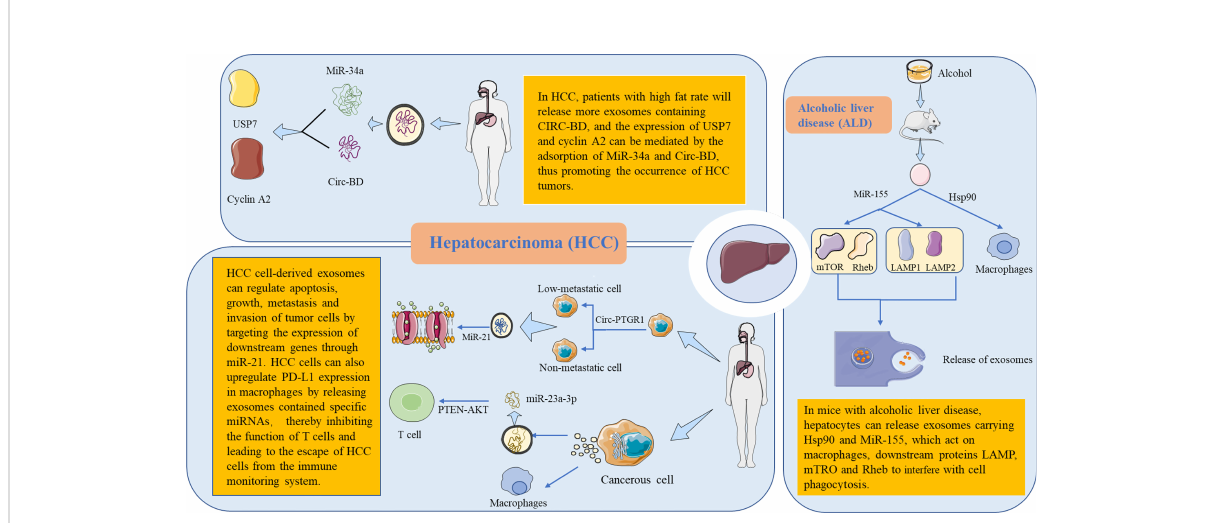
FIGURE 2 Metabolic functions and mechanisms of extracellular RNA (exRNA) in hepatocellular-derived exosomes. The liver is the body ’ s largest detoxi fi cation organ. In mice with alcoholic liver disease, liver cells interfere with the cellular function by releasing exRNA-carrying exosomes. HSP90 targets to macrophages and affects phagocytosis. MiR-155 acts on downstream proteins LAMP, MTRO, and RHEB, affecting autophagy through speci fi c activation pathways and then interfering with the release of exosomes. In patients with hepatocellular carcinoma (HCC), it was found that patients with a high fat percentage released more exosomes containing circ-BD. Circ-BD was highly expressed in adipocyte exosomes. It promotes HCC tumorigenesis by absorbing miR-34a to mediate the expression of USP7 and cyclin A2. In the process of tumor cell invasion, non-metastatic and low-metastatic cells can obtain the ability of migration and invasion through exosomes containing circ-ptgr1. In addition, HCC cell – derived exosomes can increase the expression of miR-21, which regulates the apoptosis, growth, metastasis, and invasion of tumor cells by targeting the expression of downstream genes. Endoplasmic reticulum – stressed HCC cells raise the expression of PD-L1 in macrophages by releasing exosomes containing speci fi c miRNAs. Subsequently, the miR-23a-PTEN-Akt pathway inhibits the function of T cells, leading to the escape of HCC cells from the immune monitoring system. PD-L1, programmed death-ligand